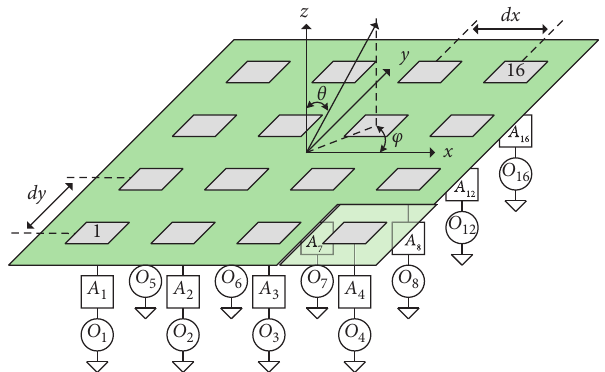
Figure 2: Example of a 4 × 4 patch antenna outspacing